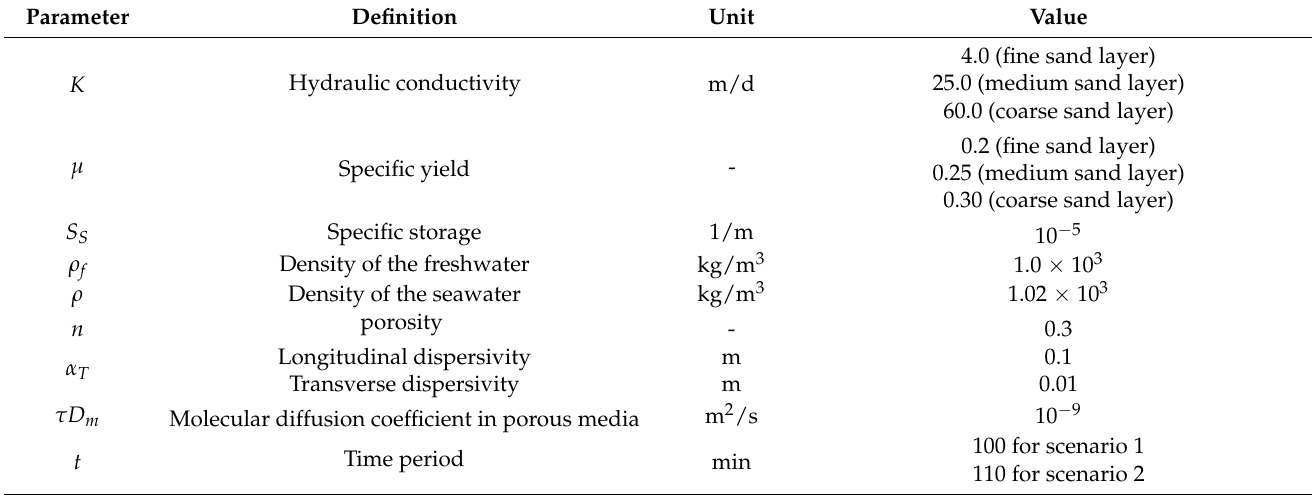
Table 1. Model parameters and their values used in the numerical